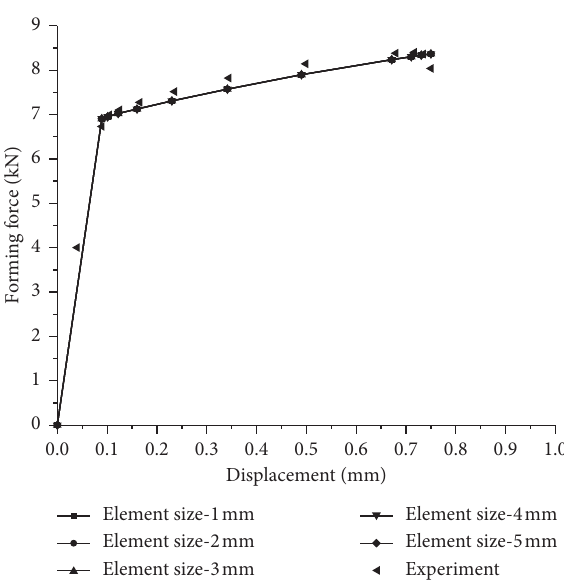
Figure 6: Displacement-forming force curves for TRB specimens from FEM and experiment.